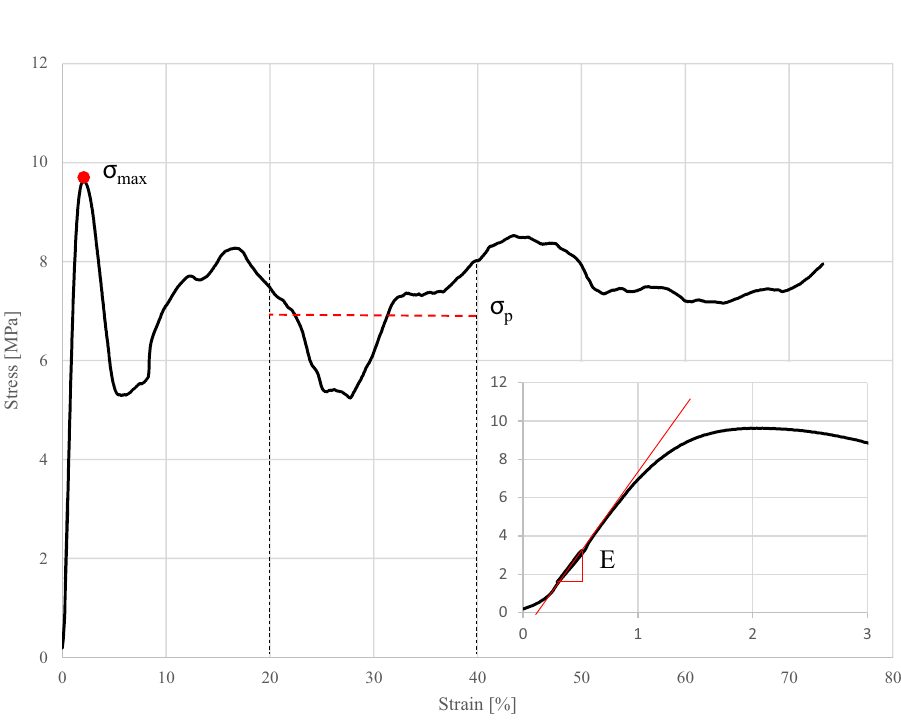
Figure 4. A typical stress–strain curve of one measured specimen is displayed. After a little toe region due to misalignment of the anvils and the specimen endfaces, the following linear region defines the compressive Modulus E and is nicely represented by the turning points of the hysteresis loop. After the first maximum σ max which marks the initial structural failure the stress drops at first and continues with irregular swelling. Despite the high swelling amplitude the plateau stress agrees well with the average stress in the areas of high